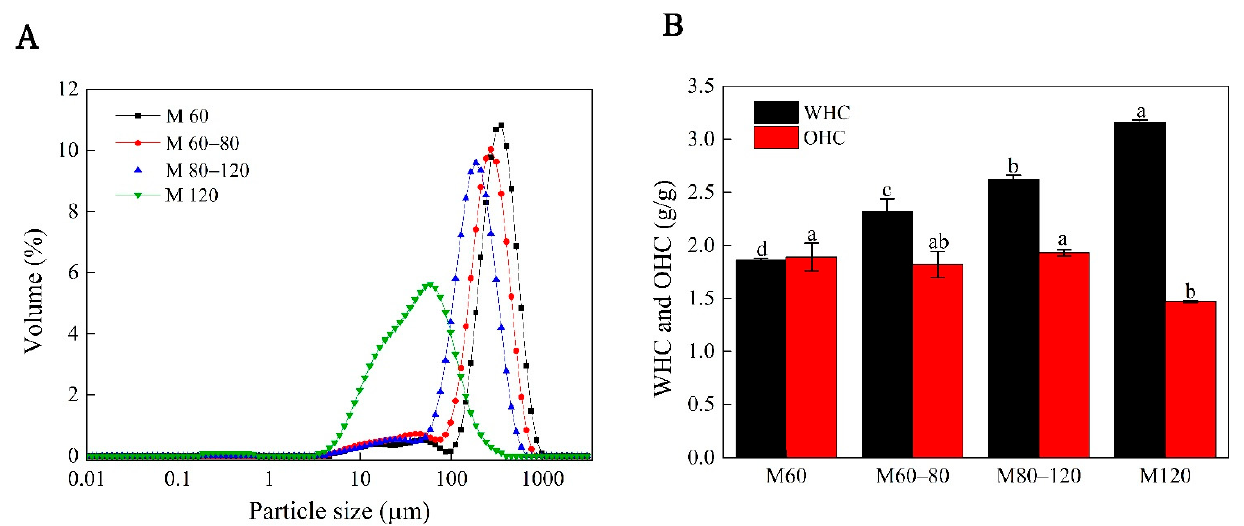
Figure 2. The particle size distribution: ( A ) water holding capacity (WHC) ( B ) and oil holding capacity (OHC) of the foxtail millet bran powder. The mean values denoted by different letters in the same column signify significant differences ( p < 0.05). Table 1. The particle size distribution of the foxtail millet bran powder.